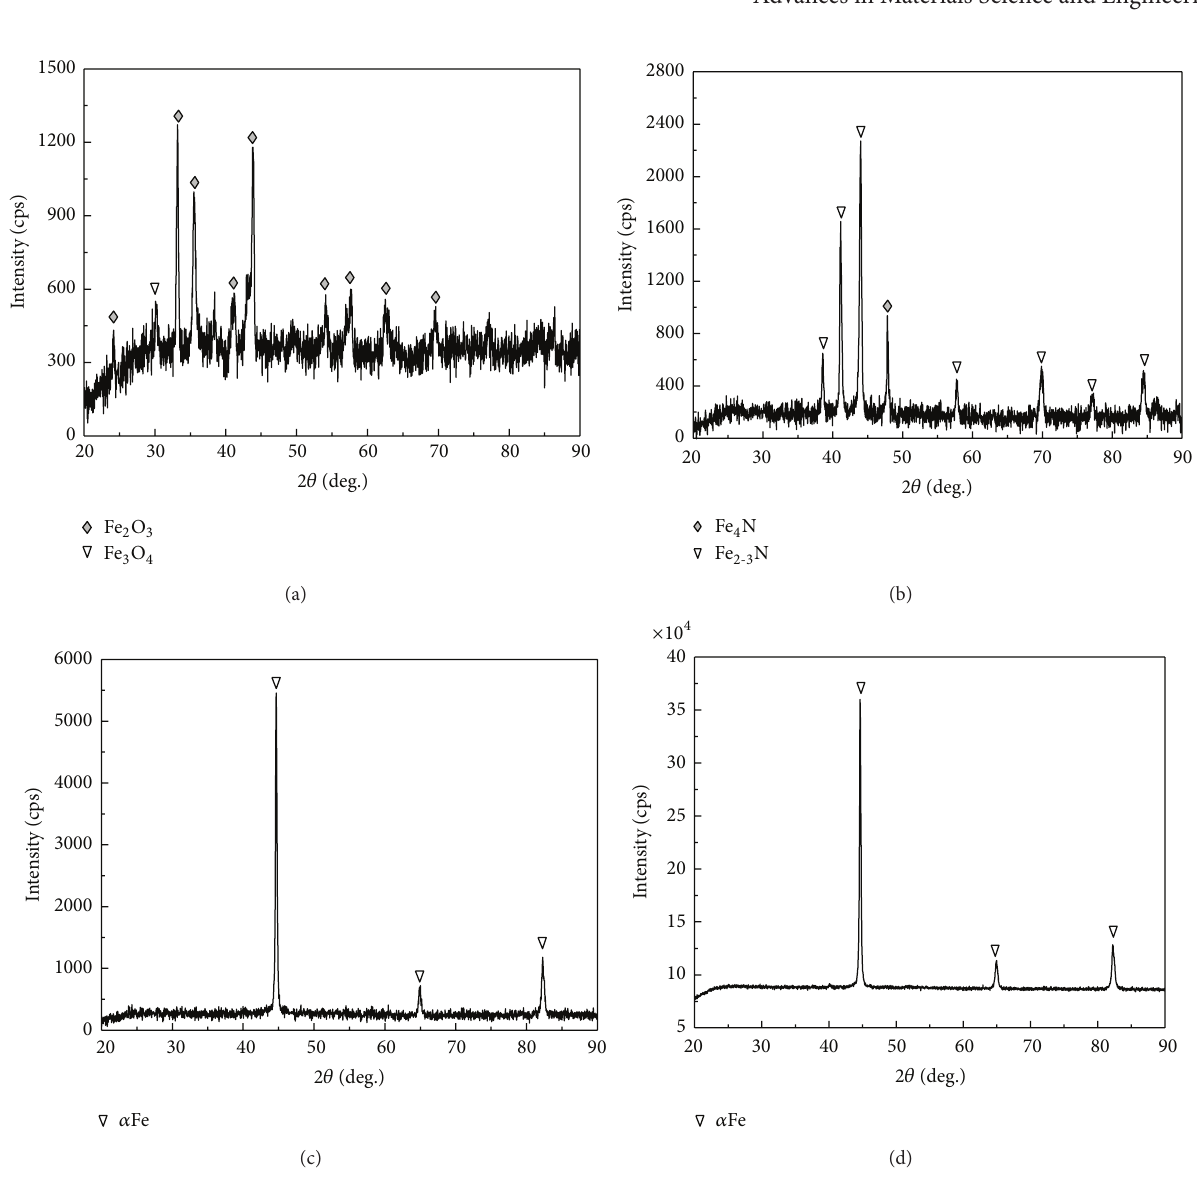
high stress [15]. Under the fatigue test conditions used in this work, the faint effect of residual compressive stress on the bottom of the indentation is completely lost. As a result, the crack initiates from the bottom of the indentation and leads to failure of the specimen (Figure 8). The differences between the experimental fatigue limits and the theoretical values can be neglected, and the fatigue limit of the indented UCN can be predicted using (2), identical to the cases of inclusions and notches with the same